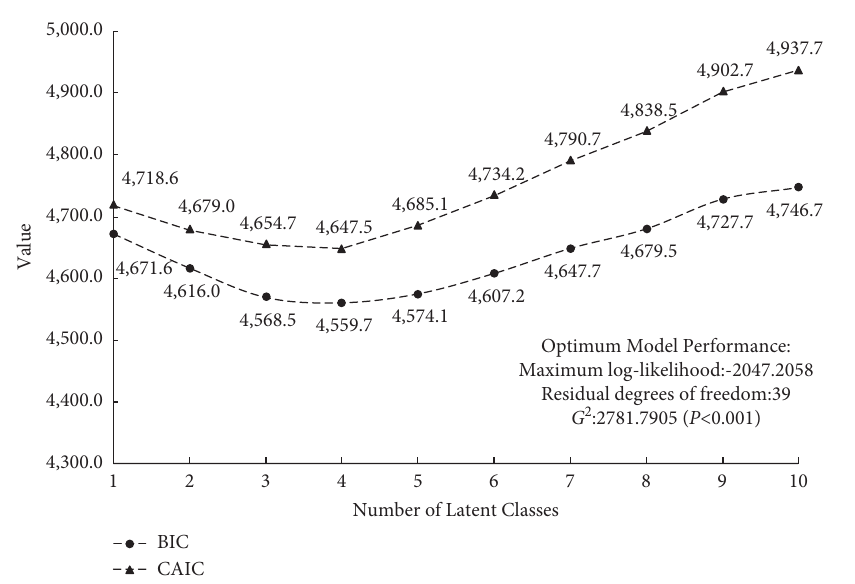
Figure 3: Optimum number of classes in the latent class model.